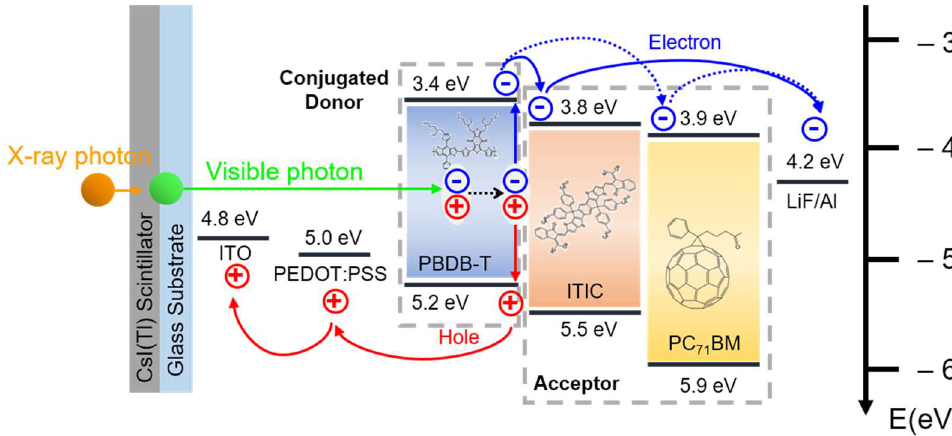
Figure 1. Energy band-diagram of the proposed organic X-ray detector with different acceptors as PC 71 BM and ITIC.